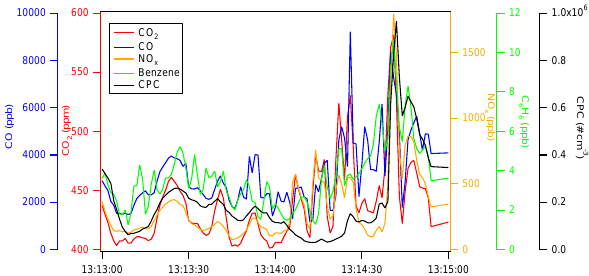
Fig. 1. CO 2 , CO, NO x , benzene, and particle number (CPC) time series during two minutes while driving. The AML was on a lightly trafficked side street and then encountered stopped traffic at 13:14:06. It was passed by a tanker truck at 13:14:41.